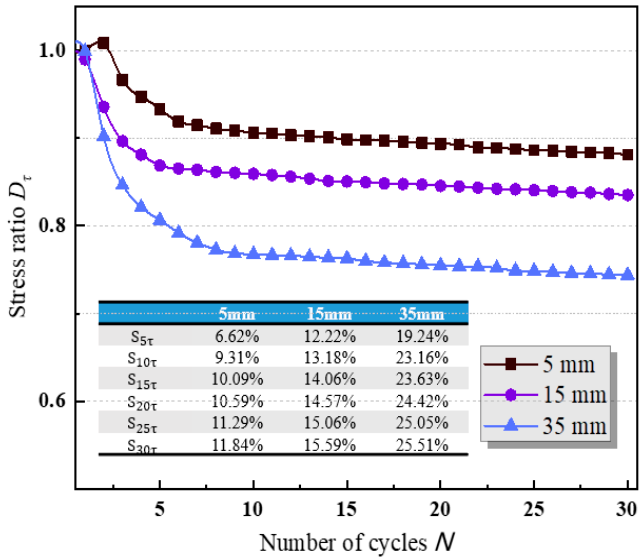
Figure 11. Stress ratio–number of cycles curve under different shear